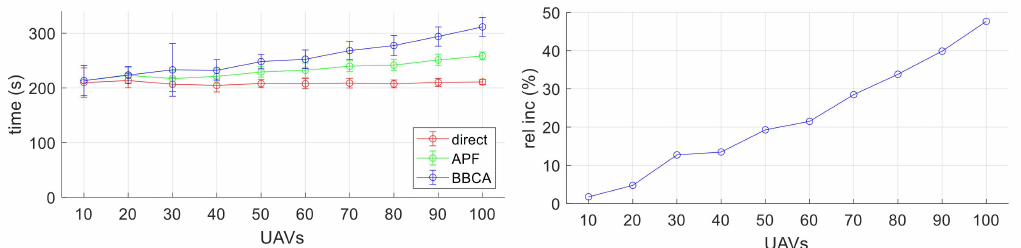
Figure 17. Multi-UAV study: flying time; average and standard deviation values (left) and relative increment